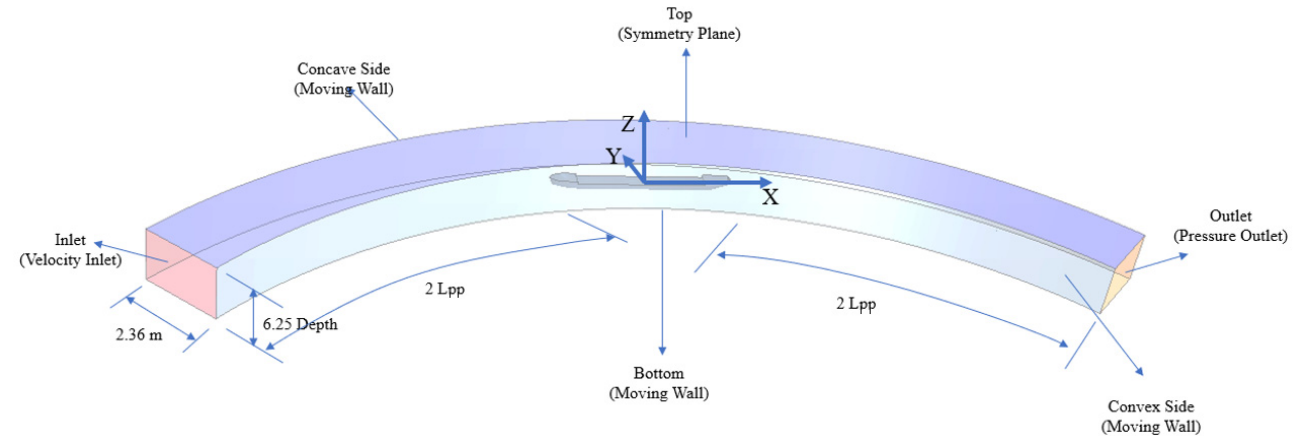
Figure 2. Three-dimensional view of the computational domain, its dimensions, and corresponding boundary conditions (R = 17.72 m). boundary conditions (R = 17.72